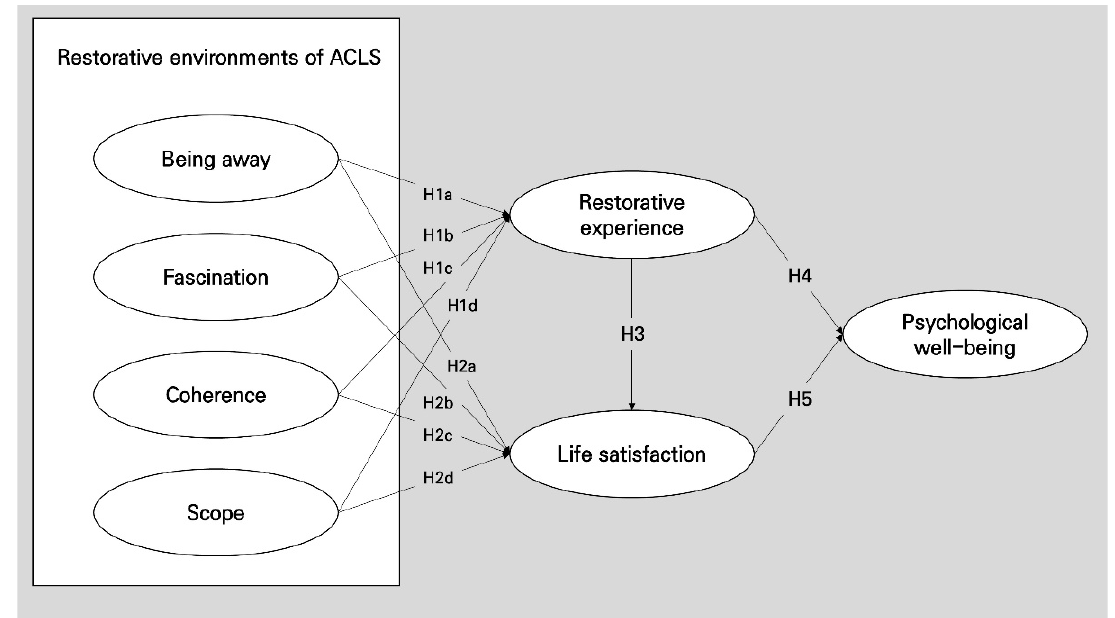
Figure 1. The conceptual model.